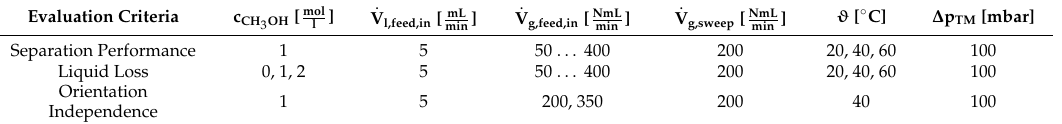
Table 3. Summary of the experimental parameter for each evaluation